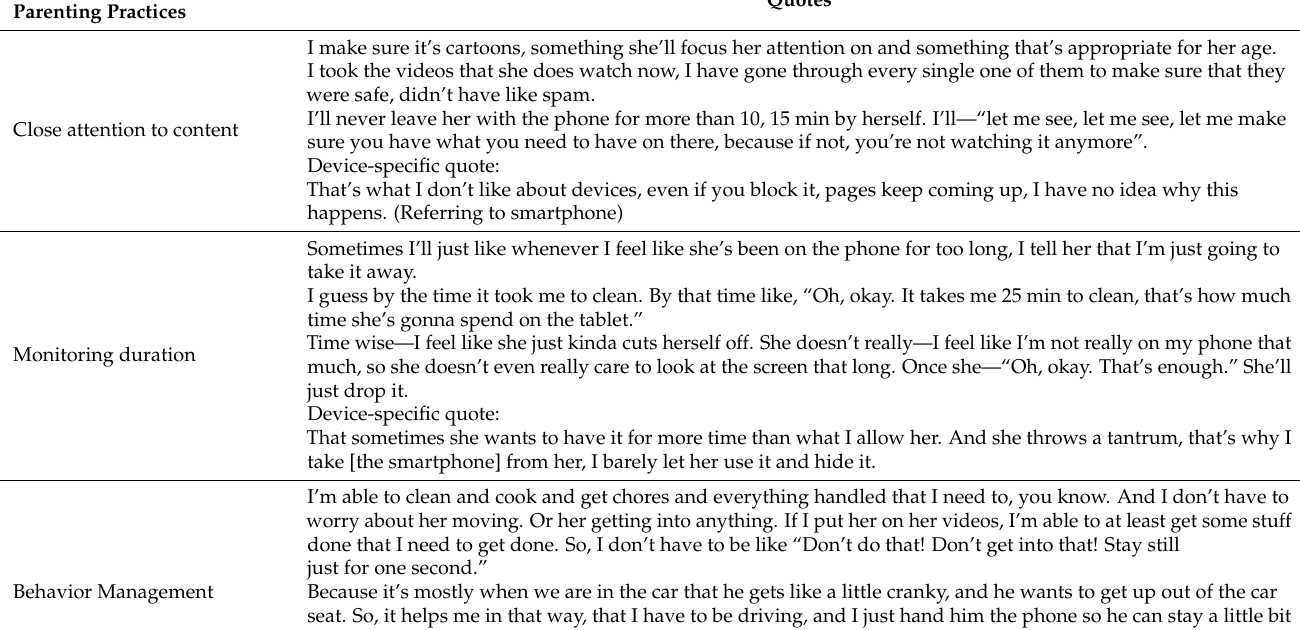
Table 3. Screen-related Parenting Practices: Representative Quotes from Interviews with Mexican American Parents of Toddlers ( n = 32)